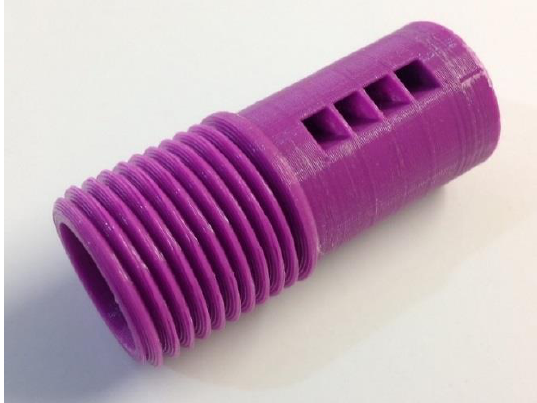
Figure 5. Variant of the mesh nozzle diaphragm. Source: authors’ development.